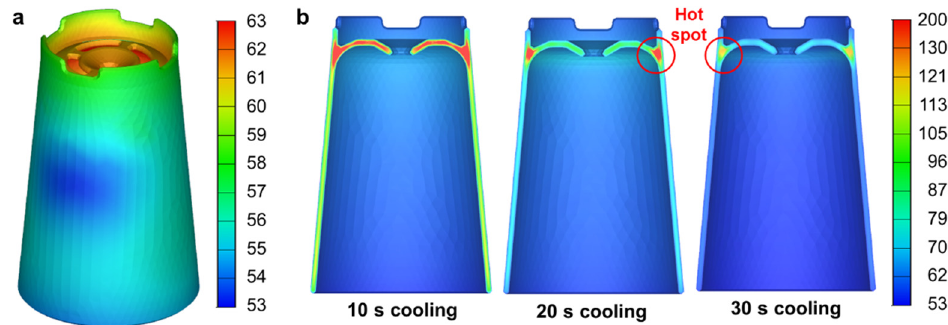
Figure 6. Injection molding simulation results: ( a ) Part surface temperatures at 30 s cooling time. ( b ) Change of the sectional temperature distributions.